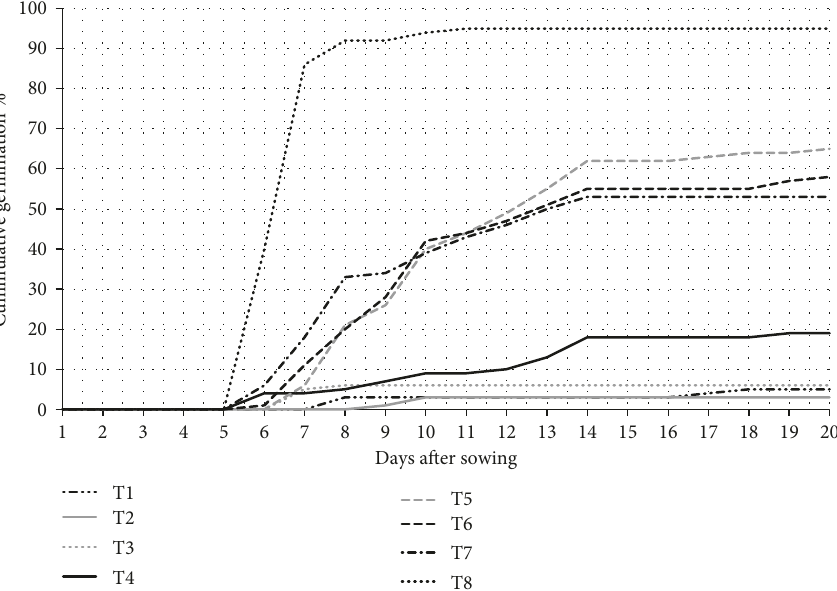
Figure 1: Germination trend of Senna spectabilis seeds, 28 days after seed